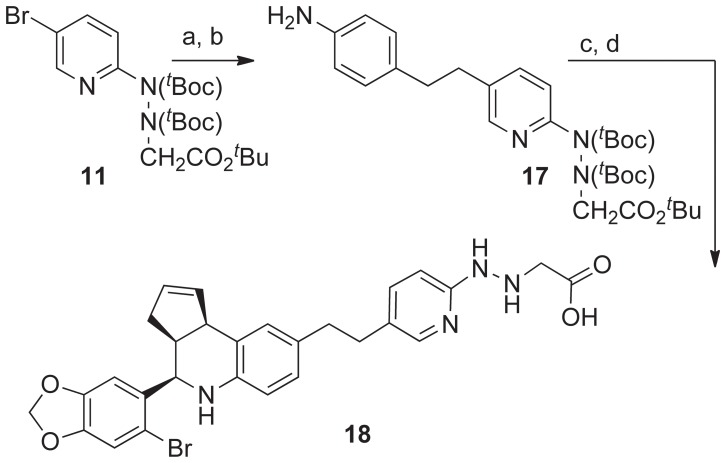
Synthesis of ethane-linked pyridin-2-yl-hydrazinylethanoic acid ligand 18.Reagents and conditions: a) 4-ethynylaniline (1.5 eq), Pd(OAc)2 (10 mol%), PPh3 (20 mol%), CuI (20 mol%), 55°C, 2 h, 68%; b) Pd/C (10%), H2(30 psi), EtOH, 3 h, 91%; c) 6-bromopiperonal (1 eq), KHSO4 (1 eq), cyclopentadiene (5 eq), rt, 24 h, 42%; d) TFA/DCM (0.8∶1.0), 45 min, 18, 80%.